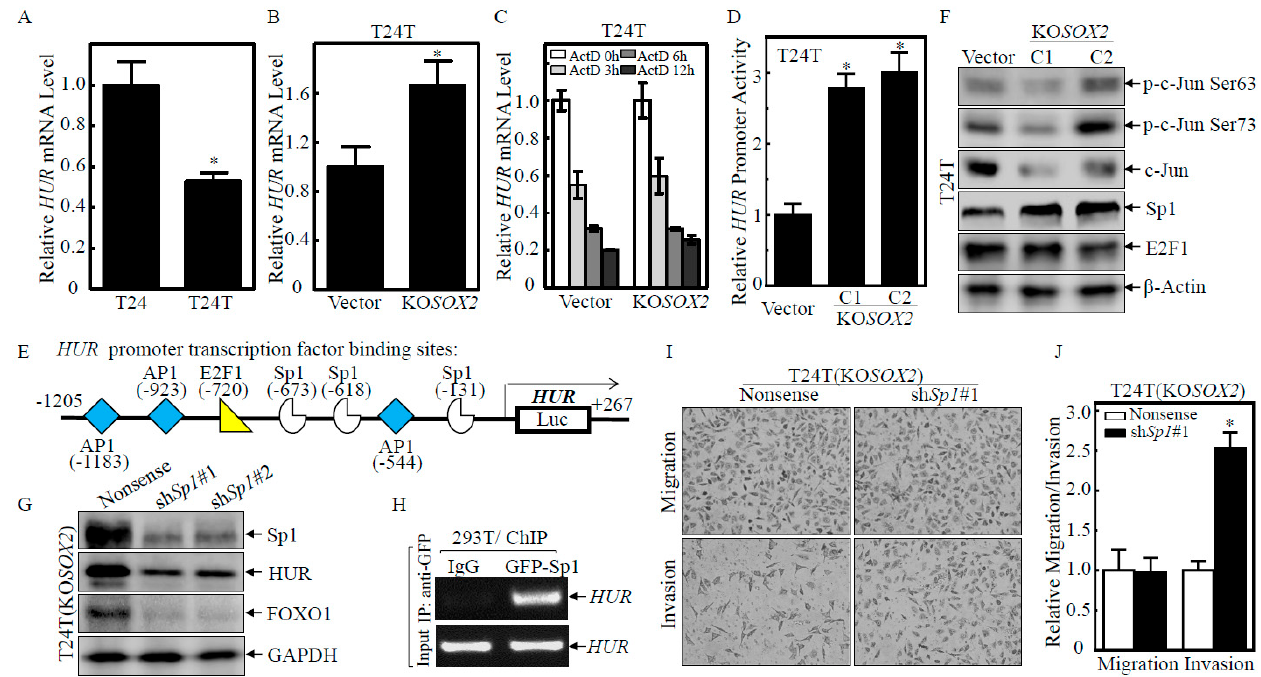
Figure 4. SOX2 inhibited HUR transcription by downregulating Sp1 protein expression. ( A , B ) The indicated cells were extracted with TRIzol reagent to isolate total RNA upon the density reaching 80–90%. HUR mRNA levels were determined with Real-time PCR by using the specific primers. GAPDH was used as an internal control. ( C ) T24T(Vector) and T24T(KO SOX2 ) cells were seeded into six-well plates. After synchronization, cells were treated with Act D for the indicated time points, then total RNA was isolated and subjected to Real-time PCR analysis to evaluate the mRNA levels of HUR and GAPDH . ( D ) The indicated cells were transfected with HUR promoter-driven luciferase reporter together with pRL-TK. The transfectants were seeded into 96-well plates and then subjected to determine HUR promoter activity. pRL-TK was used as an internal control to normalize transfection efficiency. Each bar indicates the mean ± SD from three replicate assays. ( E ) The diagram shows the transcription factors which could potentially bind to the human HUR promoter region. ( F , G ) Western blot was used to detect the protein levels of p-c-Jun Ser63, p-c-Jun Ser73, c-Jun, and Sp1 in T24T(Vector) and T24T(KO SOX2 C1/C2) cells. β -Actin was used as a protein loading control. ( G ) shRNAs targeting the human Sp1 gene were transfected into T24T(KO SOX2 ) cells to knock down Sp1 expression stably. Western blot was used to analyze the indicated protein expression; GAPDH was used as the protein loading control. ( H ) The 293T cells with overexpressing GFP-tagged Sp1 were employed for ChIP assay using an anti-GFP antibody to test the interaction of Sp1 with HUR mRNA. ( I , J ) The invasion abilities of T24(KO SOX2 /Nonsense) versus T24(KO SOX2 /sh Sp1 #1) cells were determined using a BD BioCoat TM Matrigel TM Invasion Chamber. The asterisk (*) indicates a significant difference in invasion abilities in comparison to its nonsense control transfectant ( p < 0.05). The bars are presented as the mean ± SD from three independent experiments. 2.5. SOX2-Promoted SKP2 Transcription and in Turn Mediated Sp1 Protein Degradation To elucidate the underlying mechanism of the SOX2 inhibition of Sp1 expression, the expression of Sp1 mRNA was examined, and there was no significant change in the Sp1 mRNA levels in T24T(KO SOX2 C1/C2) and T24T(Vector) cells (Figure 5A), indicating that Sp1 might be regulated at levels of protein degradation or translation. To test this, MG132 and Cycloheximide (CHX) were employed. A degradation assay showed that the marked protein degradation of accumulated Sp1 could be observed within 6 h in T24T(Vector) upon CHX incubation, while this degradation was not seen for as long as 12 h in T24T(KO SOX2 ) cells (Figure 5B), demonstrating that SOX2 negatively regulated Sp1 protein stability. The ubiquitin-proteasome system is one of the major mechanisms responsible for protein degradation in eukaryotes [23]; Ubiquitin ligating enzyme E3, such